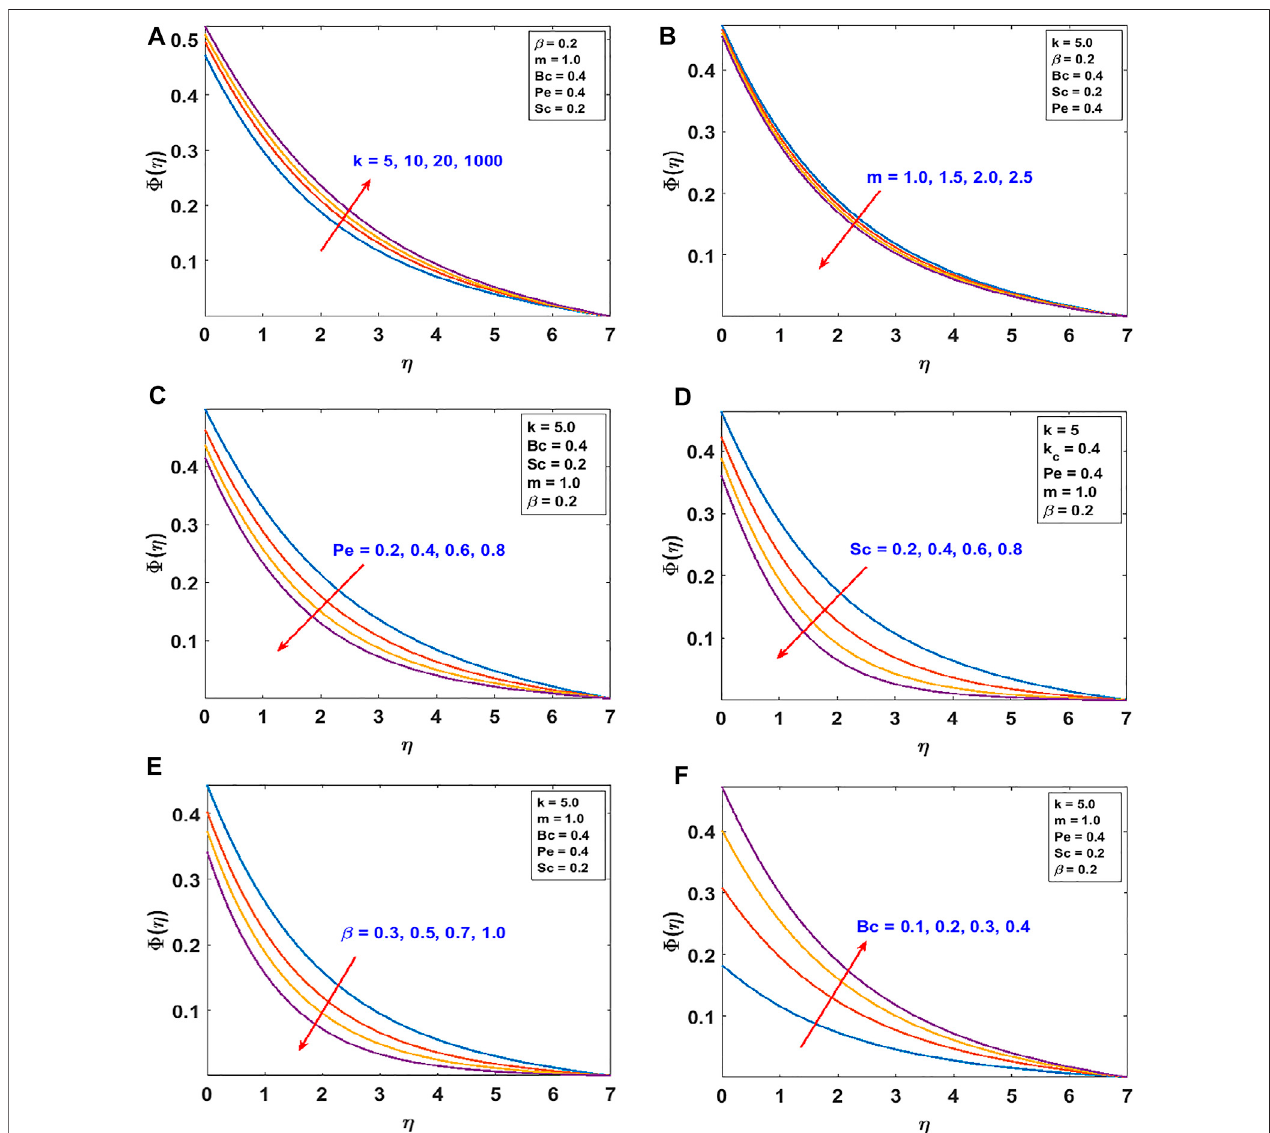
FIGURE 6 | Effect of k, m, Pe, Sc, β , and Bc on concentration pro fi le.